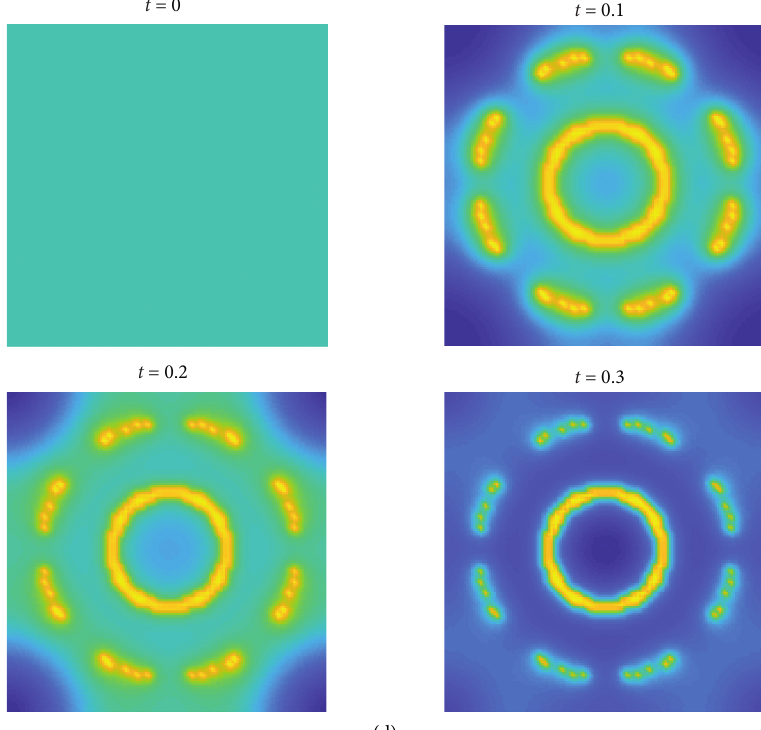
Figure 13: Numerical solution and Turing pattern of Experiment 2 with initial condition u ( x, y, 0 ) � − sin ( π ( x 2 + y 2 )) and v ( x,y, 0 ) �